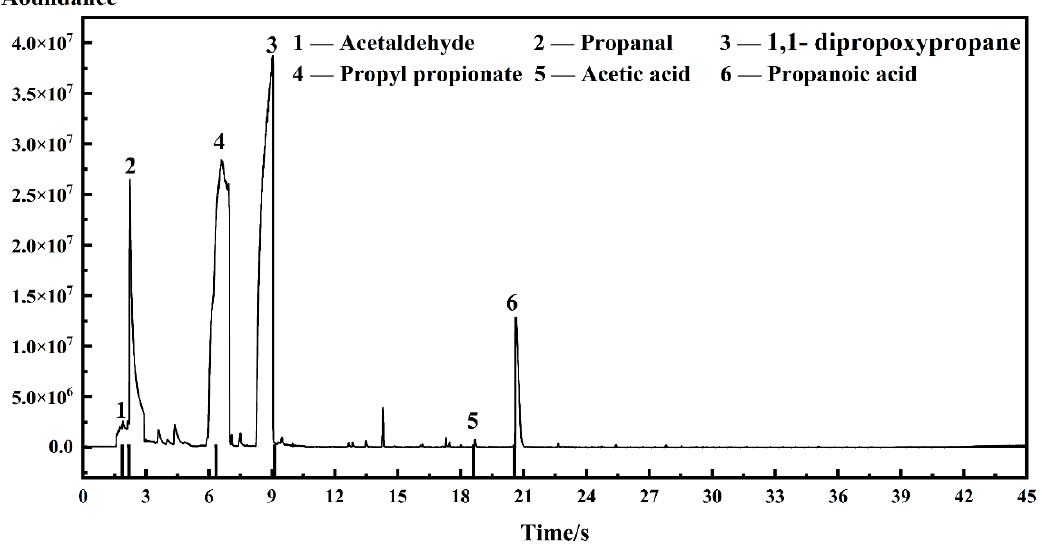
Table 2. Summary of impurity concentrations of the catalyst inks derived from GC-MS data.